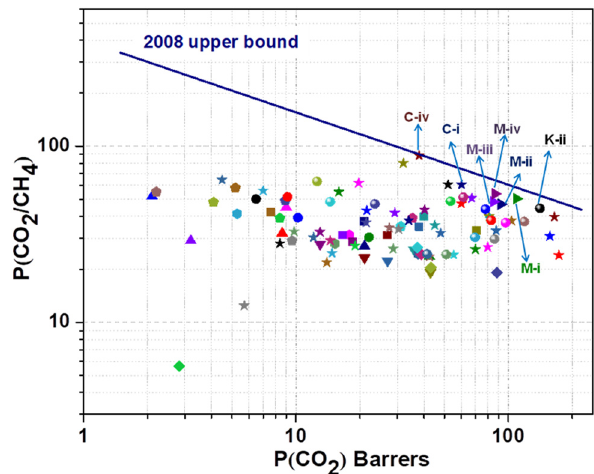
Figure 20: Robeson plot of permeability/selectivity trade - o ff for CO 2 and CH 4 gas pair. Values are taken from Tables 1 –